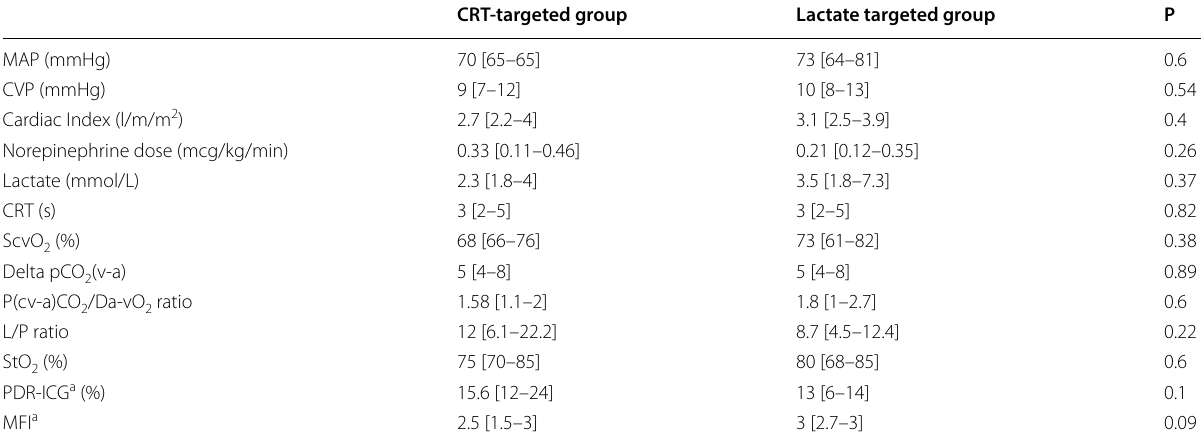
Data are presented as percentage (absolute number) or median [interquartile